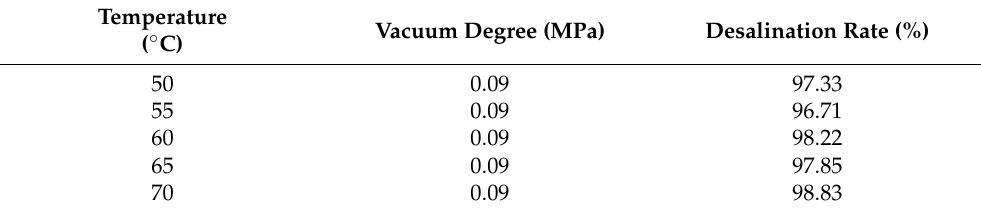
Table 2. Desalination rates of membrane module at different temperatures.